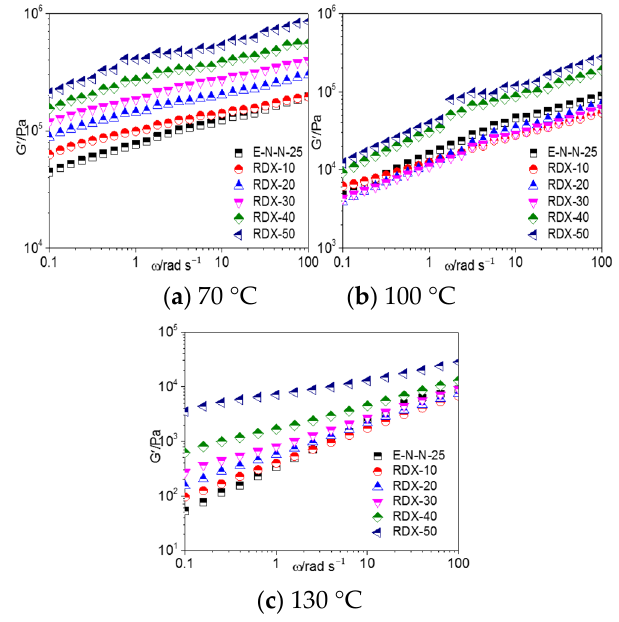
Figure 8. G ′ – ω curves of model propellants at ( a ) 70 °C , ( b ) 100 °C , and ( c ) 130 °C.